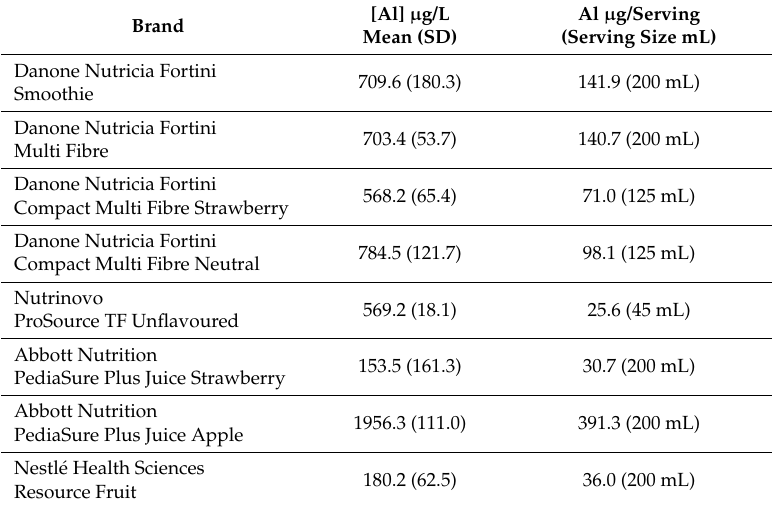
Table 2. Aluminium in ready-to-drink infant formulas designed as supplements for infants struggling to gain weight. Mean and SD are given, n = 5.